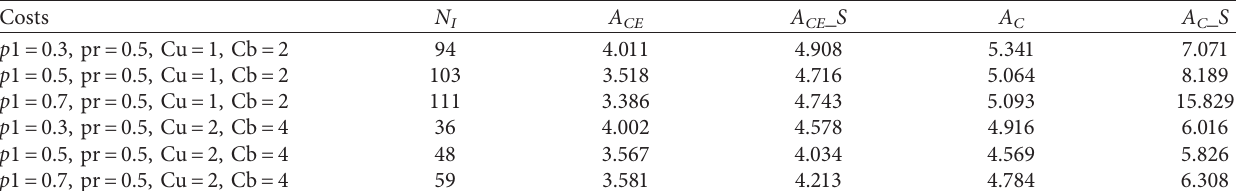
Table 3: The partial indicators of cooperative innovation network under different demand-side policies. Costs N I A